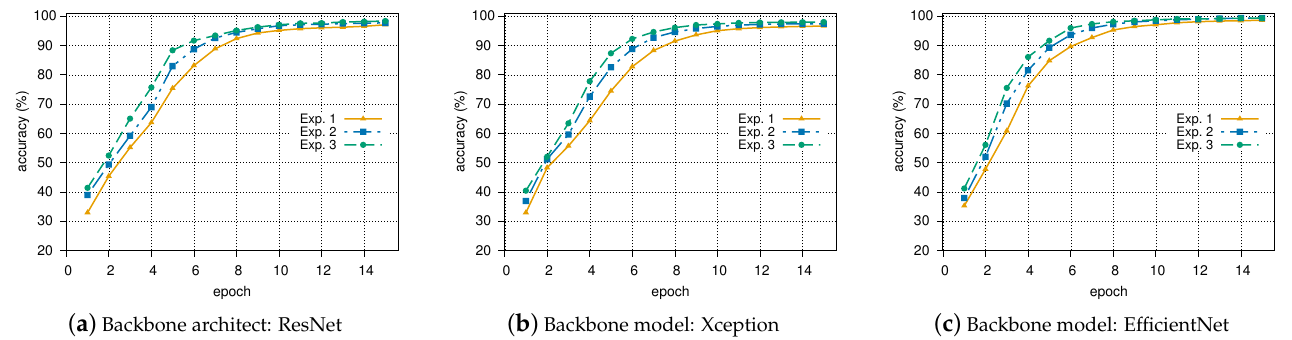
Figure 7. Performance of the proposed attention-based WBC detection approach while using afore- mentioned backbone architectures and three different ratios of train/test splits for the test